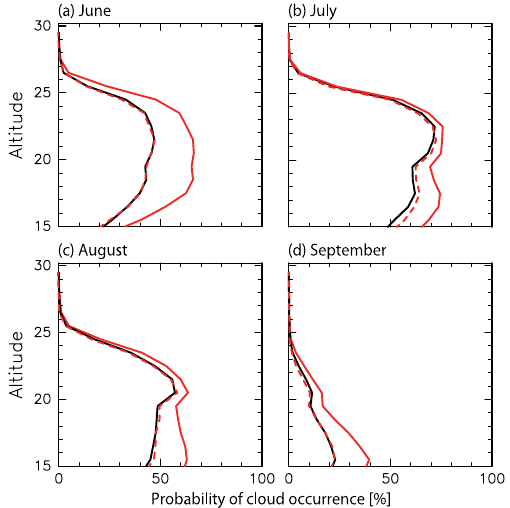
Fig. 4. Vertical profiles of the probability of PSC occurrence for (a) June, (b) July, (c) August, and (d) September from 2007 to 2011. Black solid curves indicate the PSC probability calculated using the entire data set. Red solid (broken) curves indicate the PSC proba- bility in the presence of clouds at 9–11km